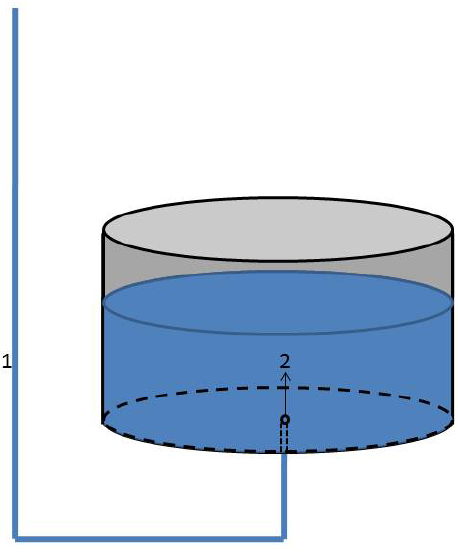
Figure 1. A pool of water being fed from below by a tube. The points indicate water (1) in the tube and (2) in the pool. The arrow indicates the direction of